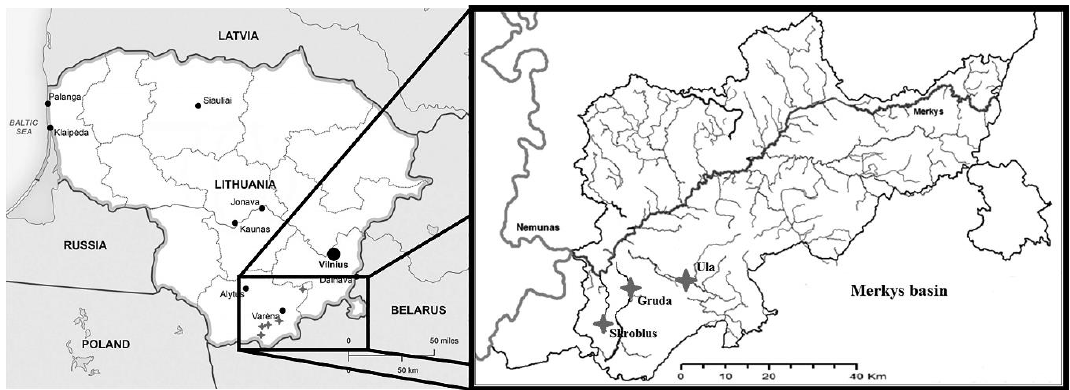
Figure 8. Map of the sampling sites from the Merkys River basin: Ula, Skroblus, and Gruda Rivers.